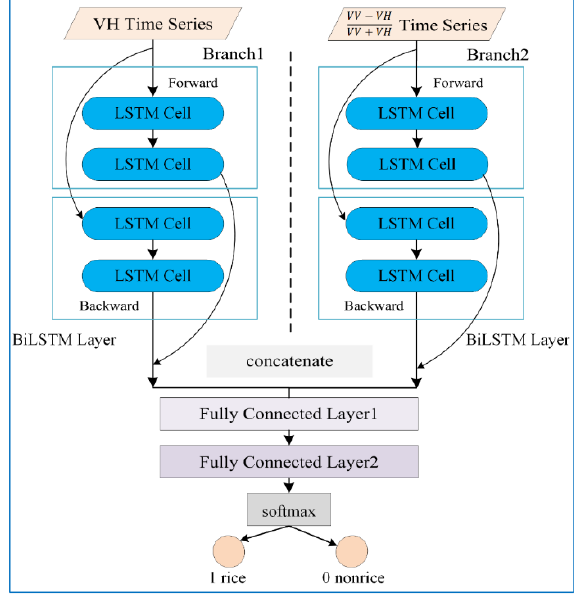
Figure 7. Structure diagram of DB-BiLSTM model.